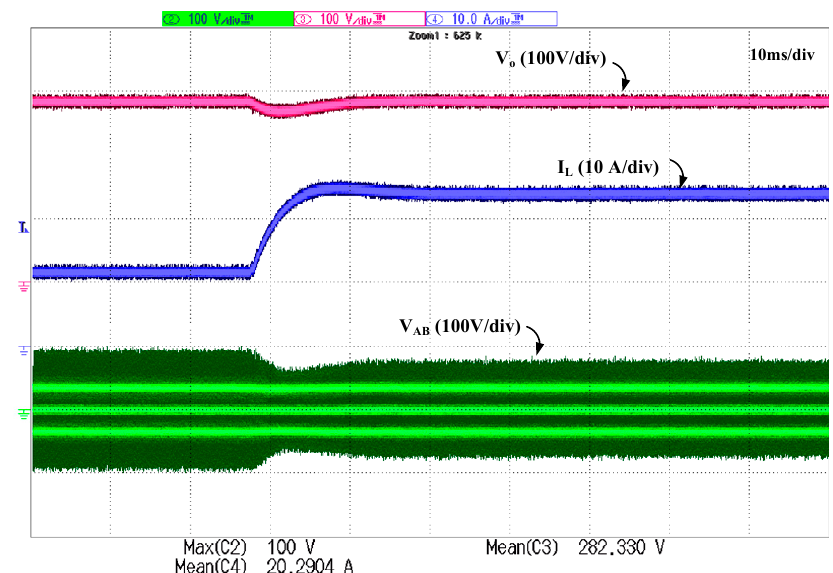
Figure 16. Hardware result for step change in load from 50% load to full load: (1) voltage V AB (100 V/div), (2) inductor current i L (10 A/div), and (3) output voltage V o (100 V/div).